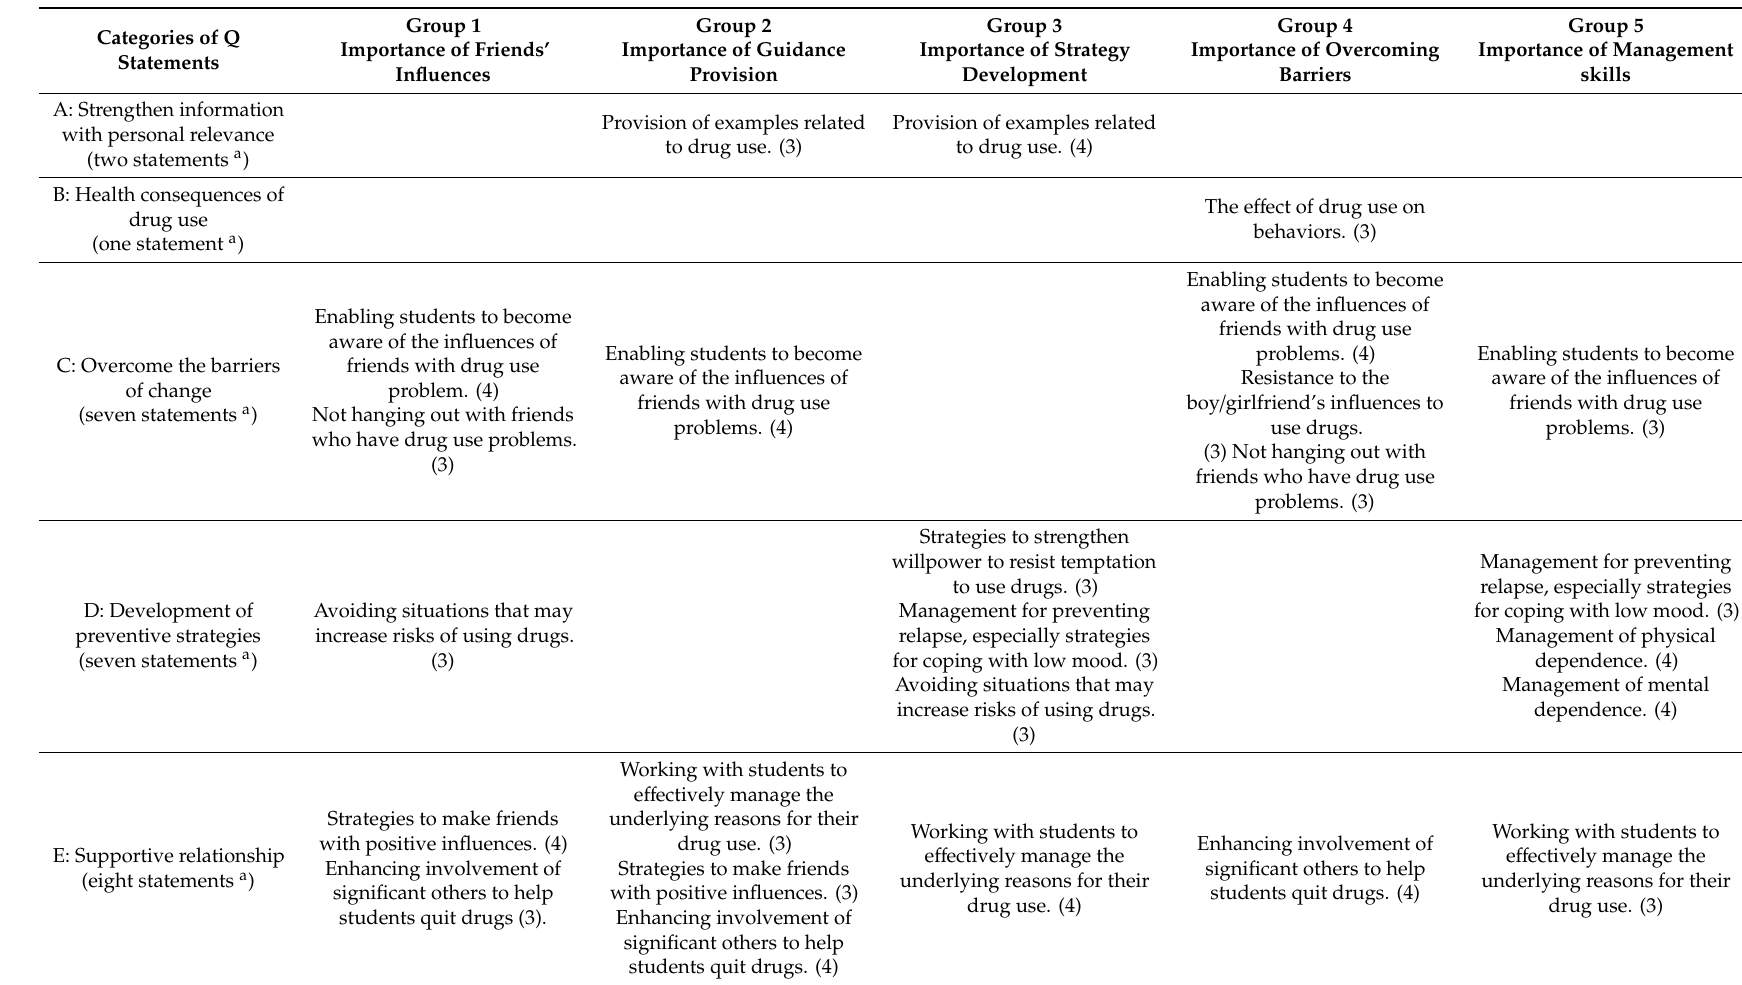
Table 3. Characterizing statements—supervisory sta ff